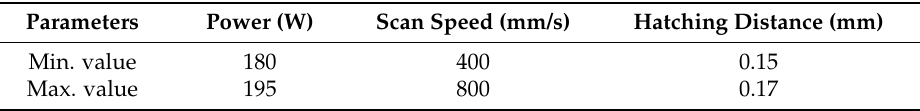
Table 2. Ranges of building parameters used for